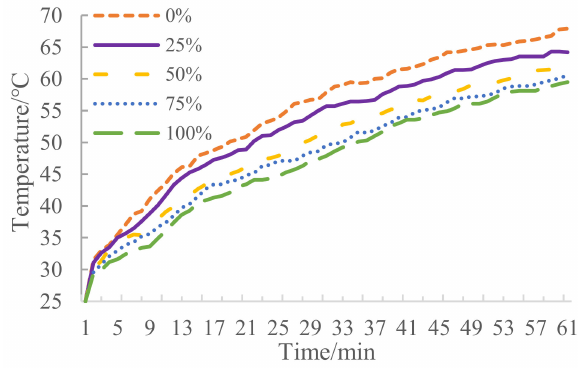
Figure 4. Surface warming curves.